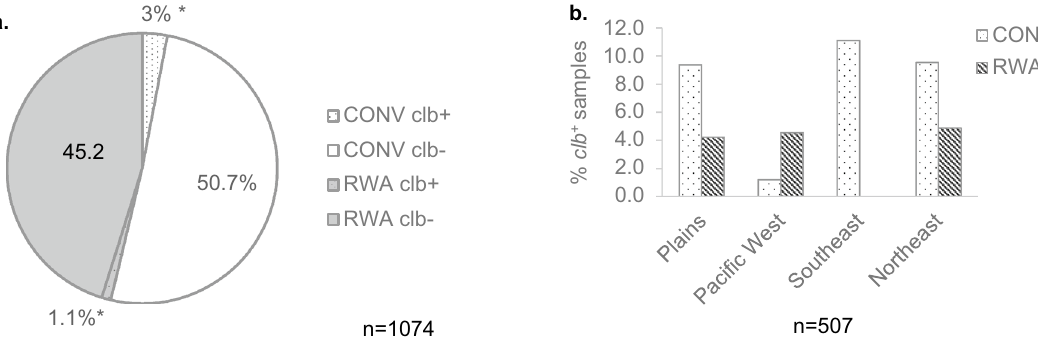
Figure 2. clb + E. coli occurring in ground beef. ( a ) Percentage prevalence of clb + E. coli in ground beef among all generic E. coli isolated; ( b ) Percentage of ground beef samples carrying clb + E. coli. Statistical significance was calculated by Fisher’s exact test. *, significant ( p < 0.05). CONV: ground beef produced from conventionally raised cattle; RWA: ground beef produced with label claim of “from beef raised without